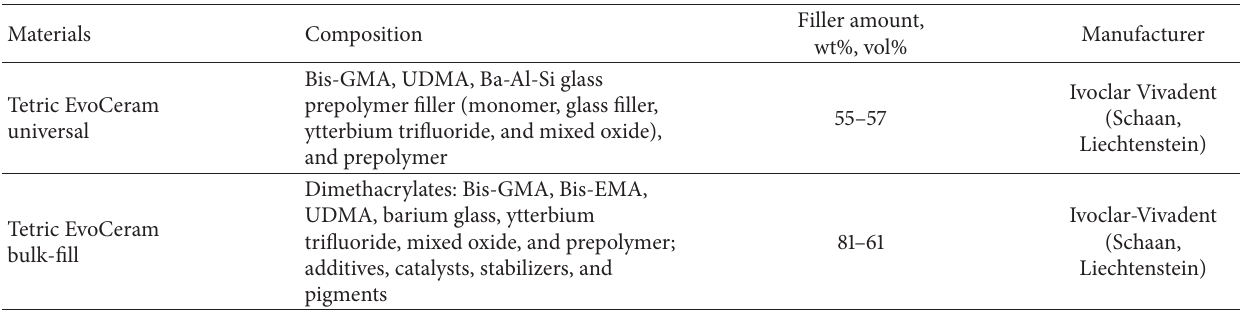
Table 1: Composition of the